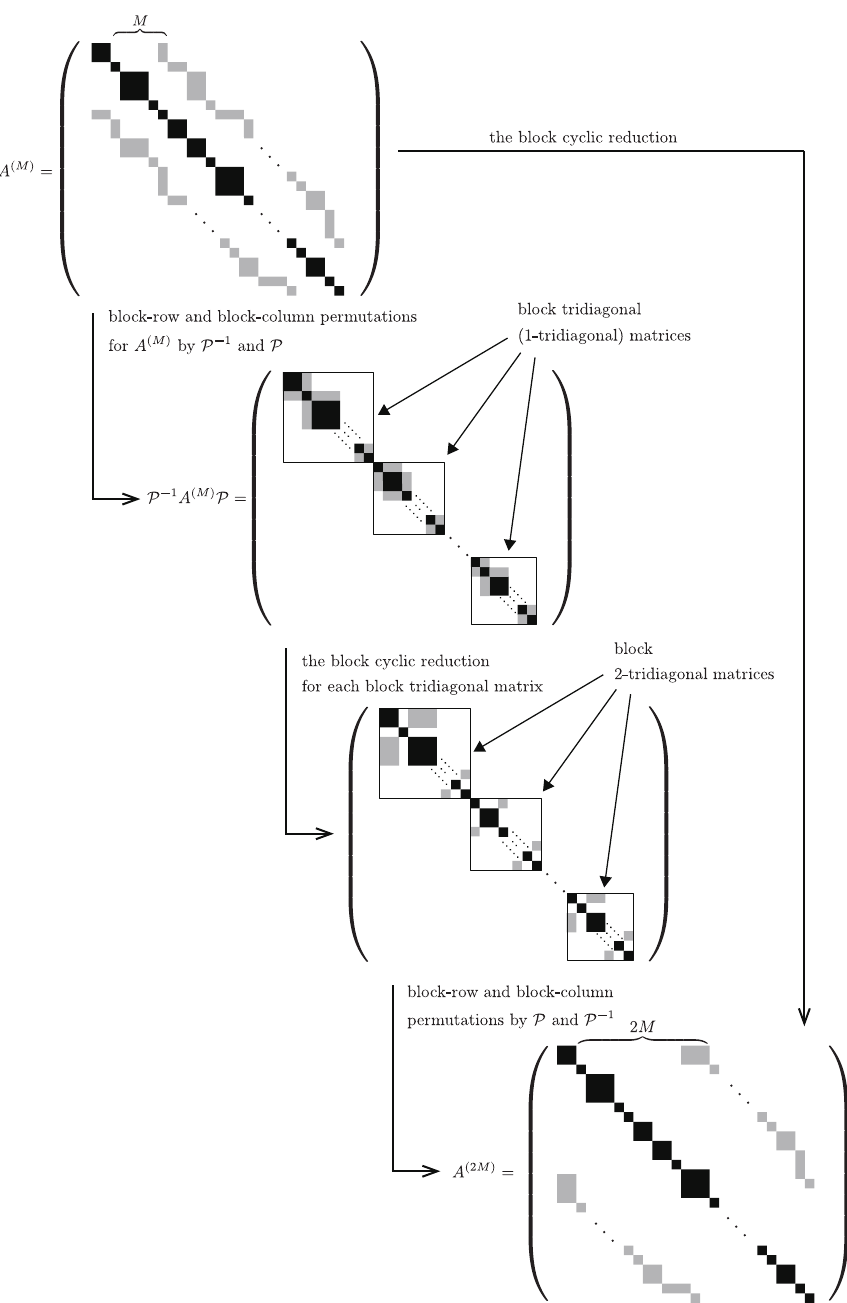
Figure 3. Coefficient matrices in the block cyclic